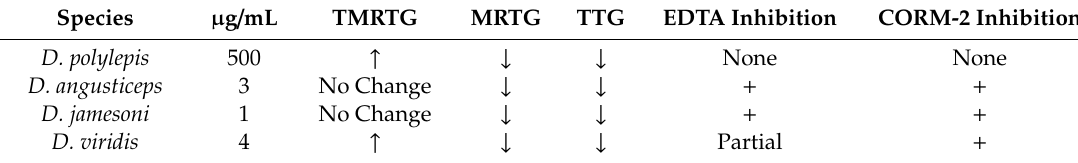
Table 2. Summary of the thrombelastographic profile and mechanism of anticoagulant activity. Species µ g /